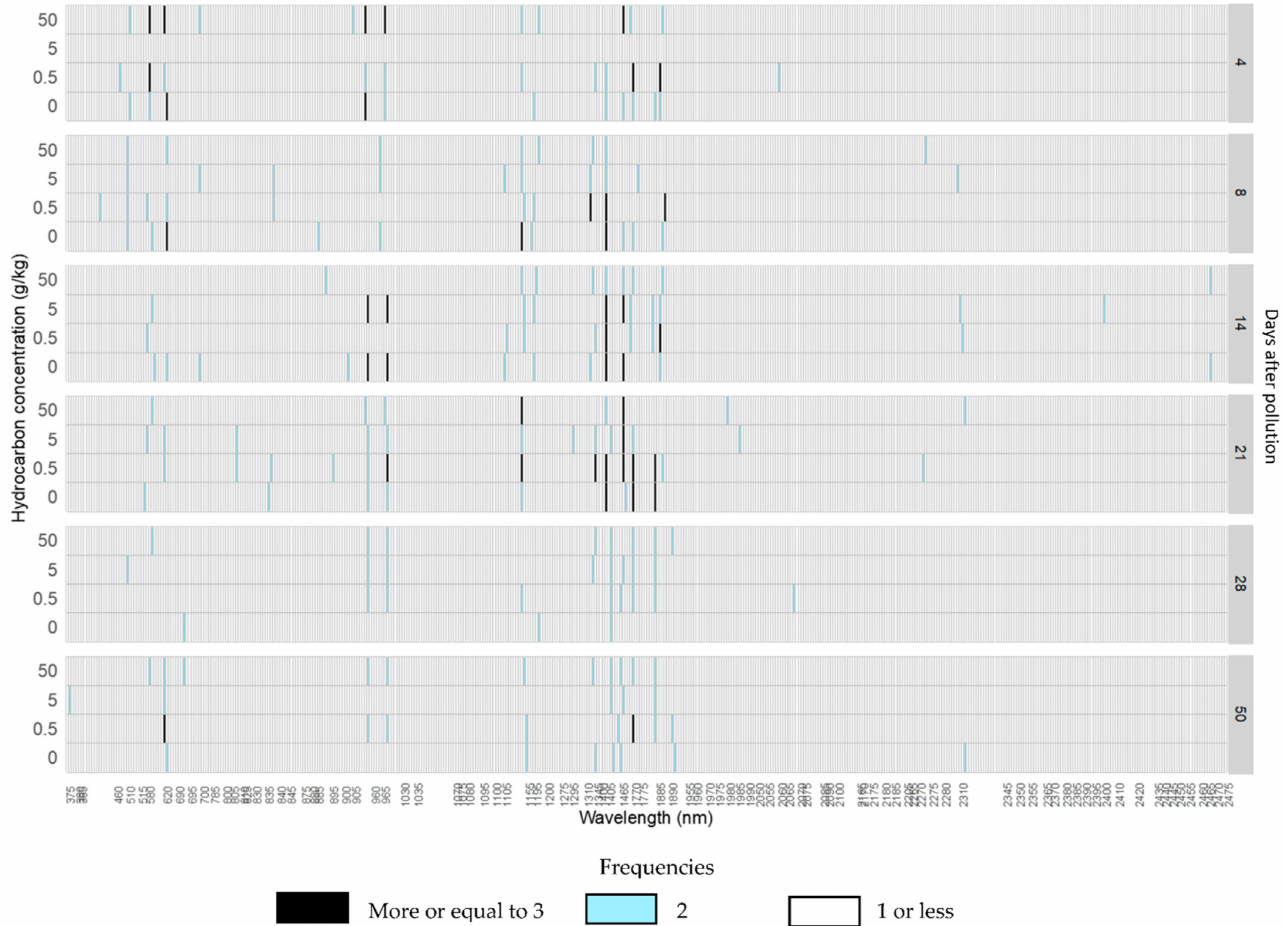
Figure 6. Histogram of the frequencies of absorption features detected in each wavelength position for each hydrocarbon concentration from 4 to 50 days after the addition of the crude oil polluted layer in willow